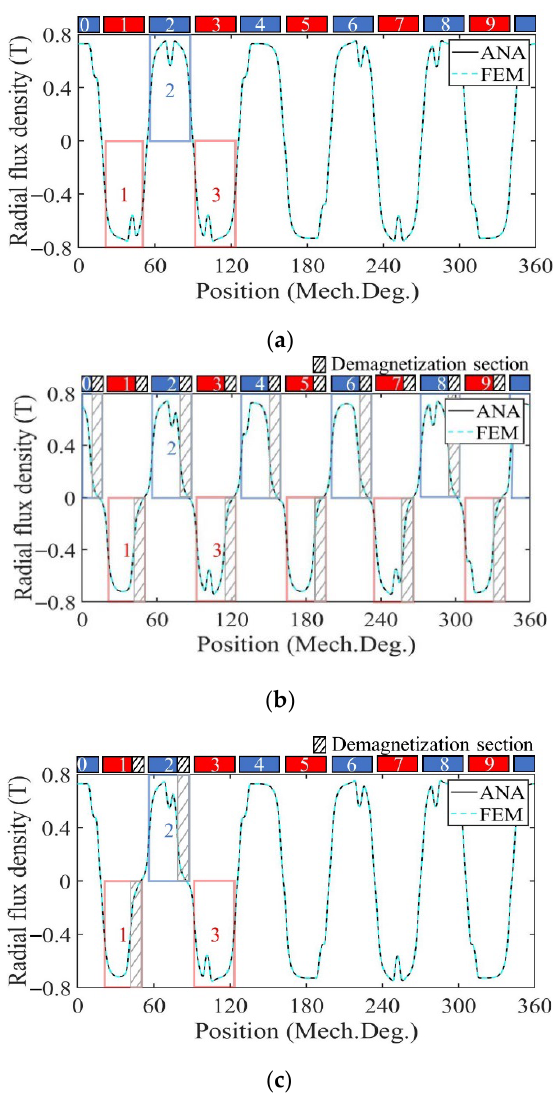
Figure 17. Radial air gap flux density comparison. ( a ) Healthy; ( b ) uniform demagnetization; ( c ) partial demagnetization.